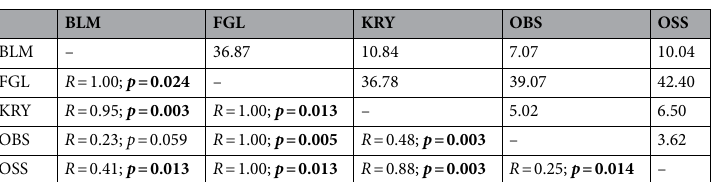
pelagic environment to forage (Fig. 2a, see Supplementary Information S2 for raw tracks). Within Kongsfjorden, the core-use area derived for each colony (i.e., 50% isopleth) showed highly restricted and delimited space use, which always overlapped at least one glacier front (Fig. 2b). Representativeness analyses suggested that most of the intracolonial variation in space use was captured by colony UD estimates (range: 84–95%, see Supplementary Information S3 for details). The global analysis of similarities (ANOSIM) indicated that the dissimilarity in space use was greater among colonies (average: 0.57; range: 0.39–0.98) than within colonies (average: 0.27; range: 0.17–0.50). This indicates that the overlap between foraging ranges was higher among birds from the same colony than among birds from different colonies (ANOSIM- R = 0.59, p = 0.001). The same pattern was observed when considering only the four colonies located within Kongsfjorden (ANOSIM- R = 0.50, p = 0.001). While showing no sign of heterogeneous dispersion among groups ( F 4,33 = 0.93, p = 0.457), the ANOSIM analysis conducted on each pair of colonies suggested that all colonies showed significant spatial segregation, except the Blomstrand (BLM)—Observas- jonsholmen (OBS) dyad (Table 2). Although the core-use area of these two colonies showed little overlap, it suggests that some birds breeding in these colonies shared similar foraging space (see raw tracks distribution in Supplementary Information S2).